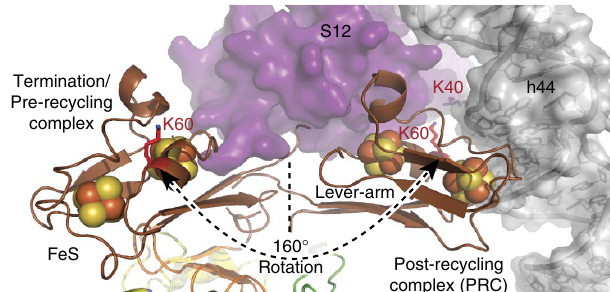
Figure 3 | Extensive movement of the FeS cluster domain. The FeS cluster domain, anchored to NBD1 via a two b -strand lever arm, swings out of the NBD cleft and converges towards the 30S subunit to occupy a cleft between the S12 r-protein and rRNA (h44) of the small ribosomal subunit. Due to this conformation change, the C a –C a distance between these highly conserved lysines in Archaea, yeast and human is reduced from 59.5Å in the pre-splitting state to 17.5Å in the